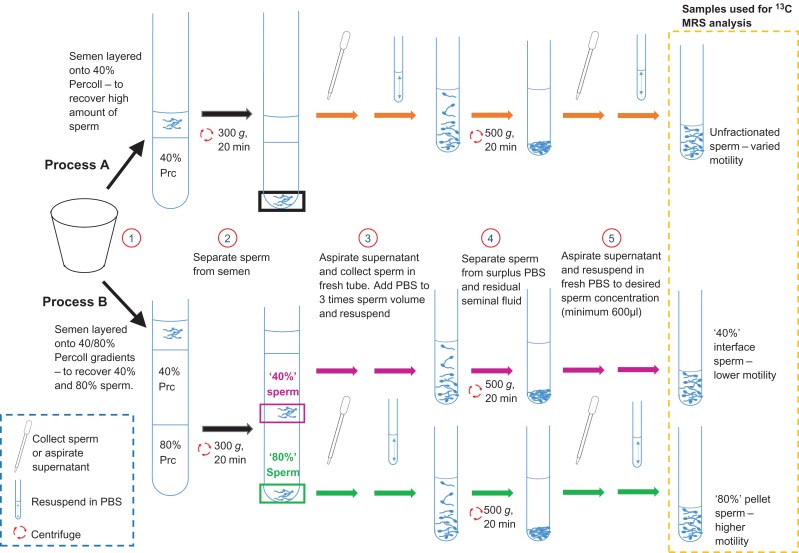
Sperm washing methods used to remove seminal plasma. Process (A) was used to yield higher concentration of sperm for aims (i) and (ii). Process (B) was used to fractionate sperm into higher average motility, ‘80%’, sperm and lower average motility, ‘40%’, sperm. See main text for further details.